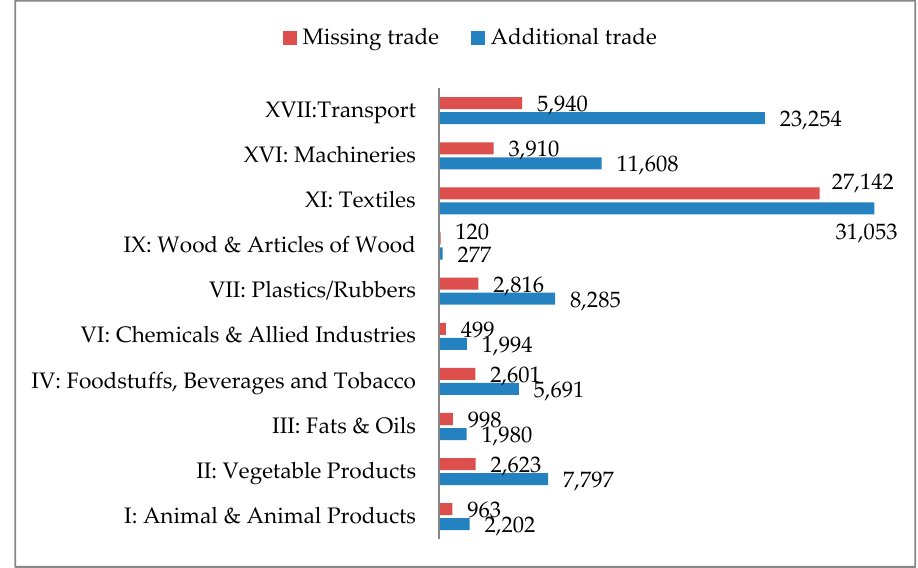
Figure 3. Trade effect due to preferences: Results for sectors with significant preference impact (CES Figure 3. Trade e ff ect due to preferences: Results for sectors with significant preference impact reference tariff). At world prices; millions of €. Source : Elaboration on data by COMEXT and TRAINS; (CES reference tari ff ). At world prices; millions of € . Source : Elaboration on data by COMEXT and 2017. TRAINS; 2017.